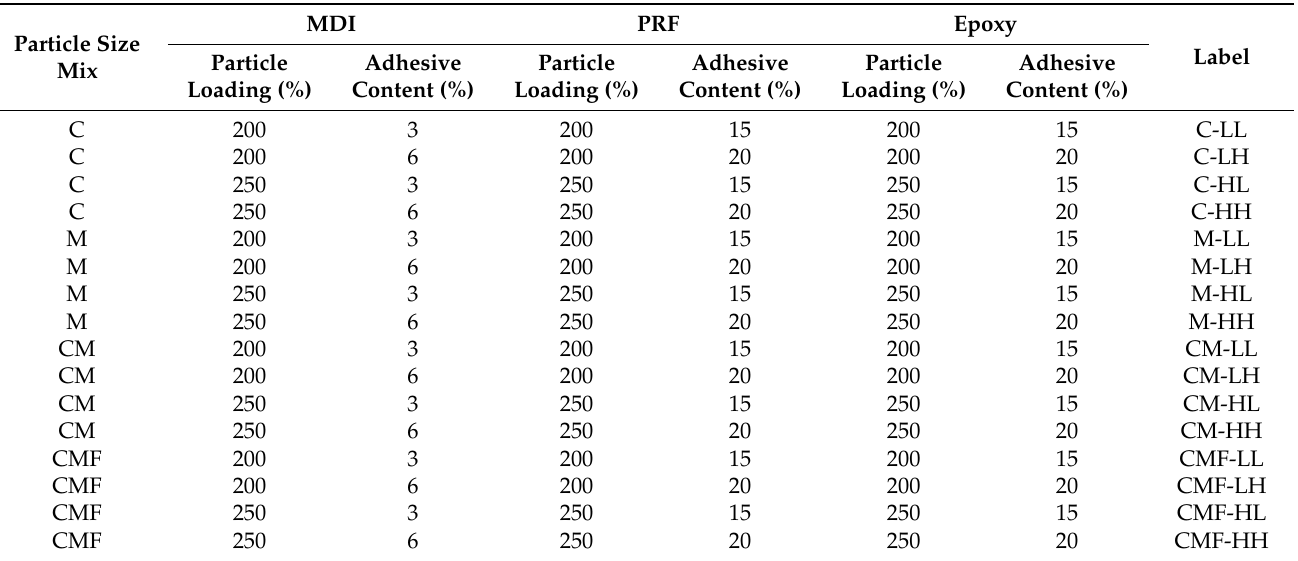
Table 4. Design and notation of ultra-low-density hemp particleboard variants per adhesive type (one of three replicates